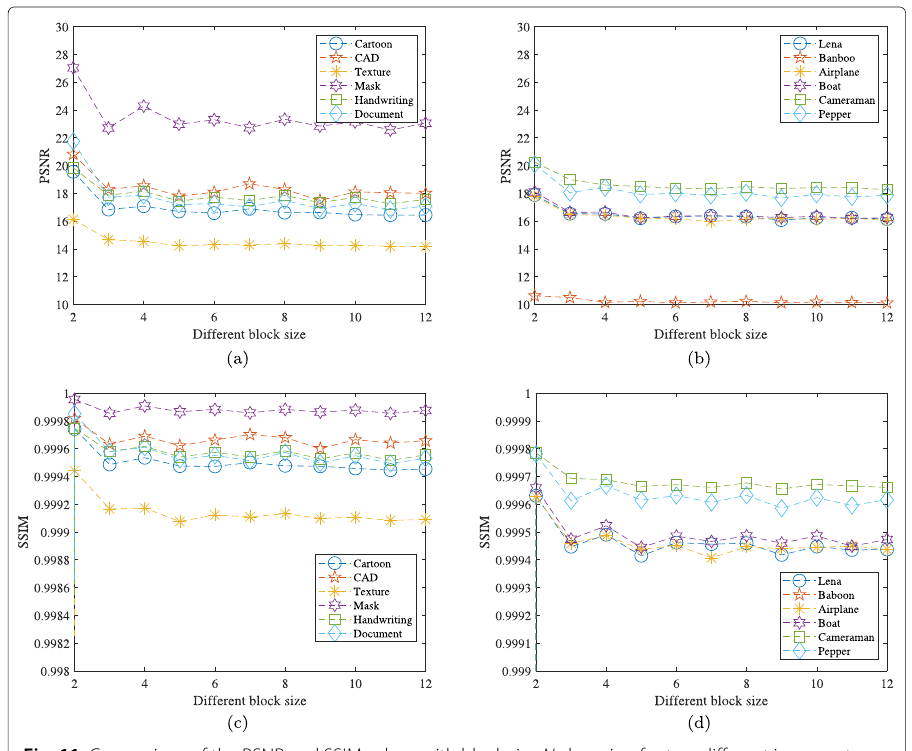
Fig. 11 Comparison of the PSNR and SSIM values with block size N changing for two different image sets: a classical binary image source, b binary image source from classical gray images. The experiment uses the maximum embedding rate in each